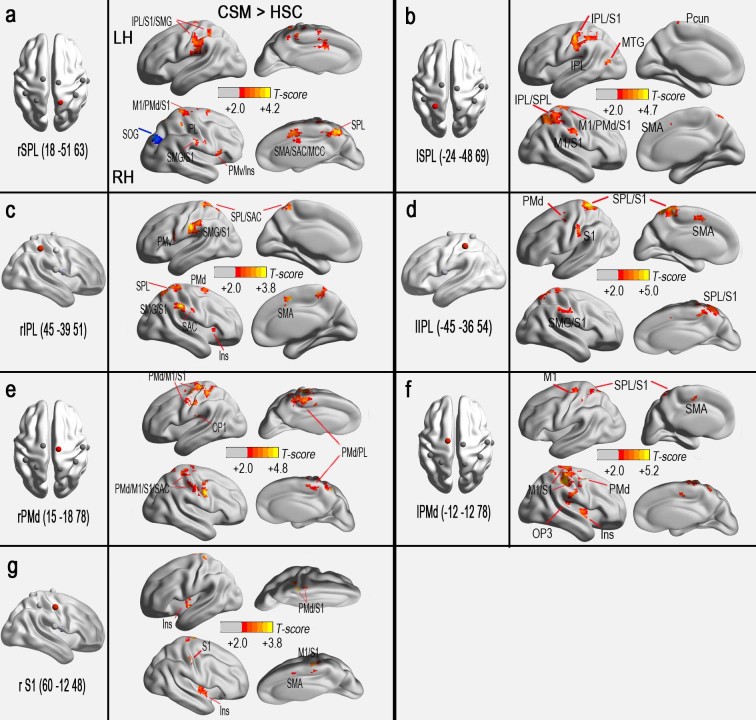
Significant group differences in the rsFC patterns of the seed regions with increased FCS (CSM > HSC, P < 0.05.The AlphaSim corrected critical cluster size was k = 23 in Fig 5a, k = 23 in Fig 5b, k = 21 in Fig 5c, k = 21 in Fig 5d, k = 21 in Fig 5e, k = 21 in Fig 5f, k = 22 in Fig 5g). The colour-bar indicates the t-scores. Yellow-red colours denote increased rsFC in patients.